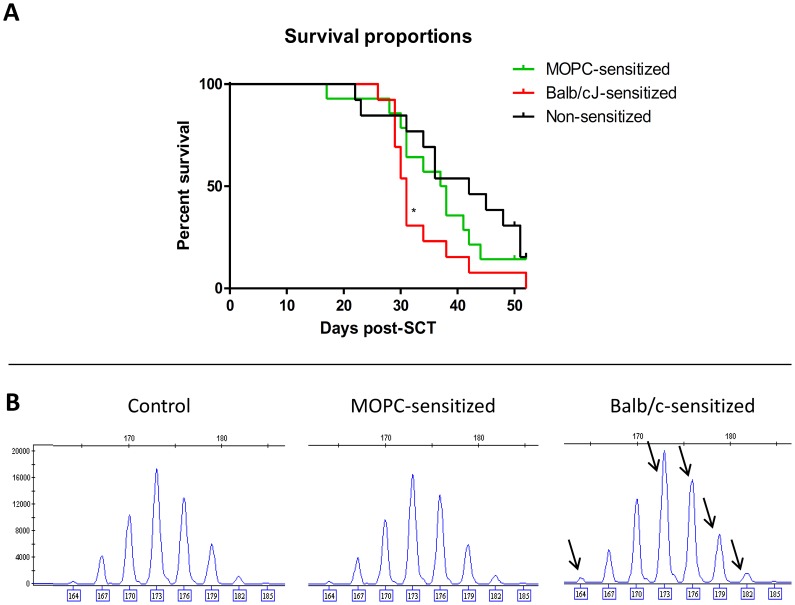
Graft-versus-myeloma and graft-versus-host reactivity.B10.D2 donor mice were not sensitized (”controls”) or previously sensitized by injection of MOPC315.BM myeloma cells or Balb/cJ splenocytes (“MOPC-sensitized” or “Balb/c-sensitized”, respectively). (A) Survival proportions of Balb/cJ recipient mice (N = 13–14/group) that were irradiated and received a graft from non-sensitized, “MOPC-sensitized” or “Balb/c-sensitized” B10.D2 mice. Recipient mice were sacrificed when severe GvHD symptoms (GvHD score ≥ 8/10) or apathy were present. *p = 0.038 (Log-Rank Test). (B) Representative Vβ15 spectratype histograms for CD4 T cells isolated from splenocytes of non-sensitized B10.D2 mice ( = control), “MOPC-sensitized” or “Balb/c-sensitized” B10.D2 mice. Arrows indicate skewed peaks (i.e. mean peak area> mean+3SD of corresponding control peak).